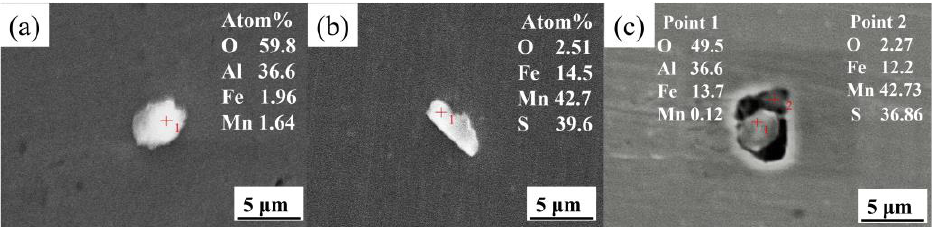
Figure 1. SEM images and EDS results of typical inclusions in RE-free steel: ( a ) Al 2 O 3 , ( b ) MnS, and ( c ) Al 2 O 3 -MnS complex